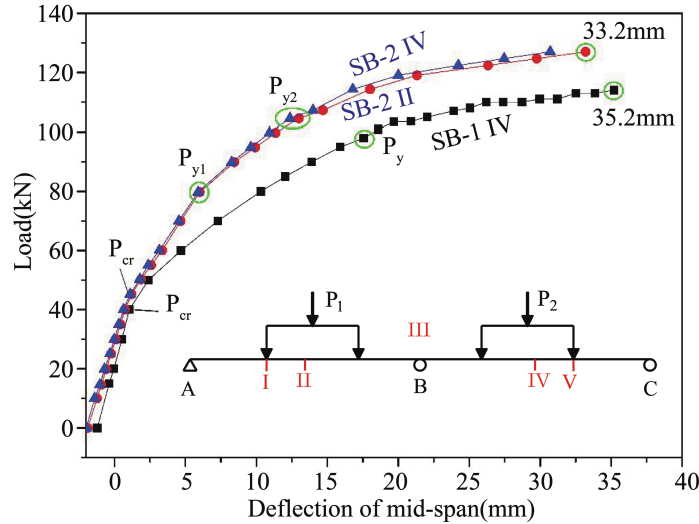
Figure 4. Load–deformation curves of SB-1 and SB-2 beams. P1 and P2 are applied loads, I, II, III, IV, and V are specific points along the beams where beam behavior under loading was analyzed, P cr is the cracking load, P y is the load at which the steel reinforcement yielded, and P u is the ultimate load at beam